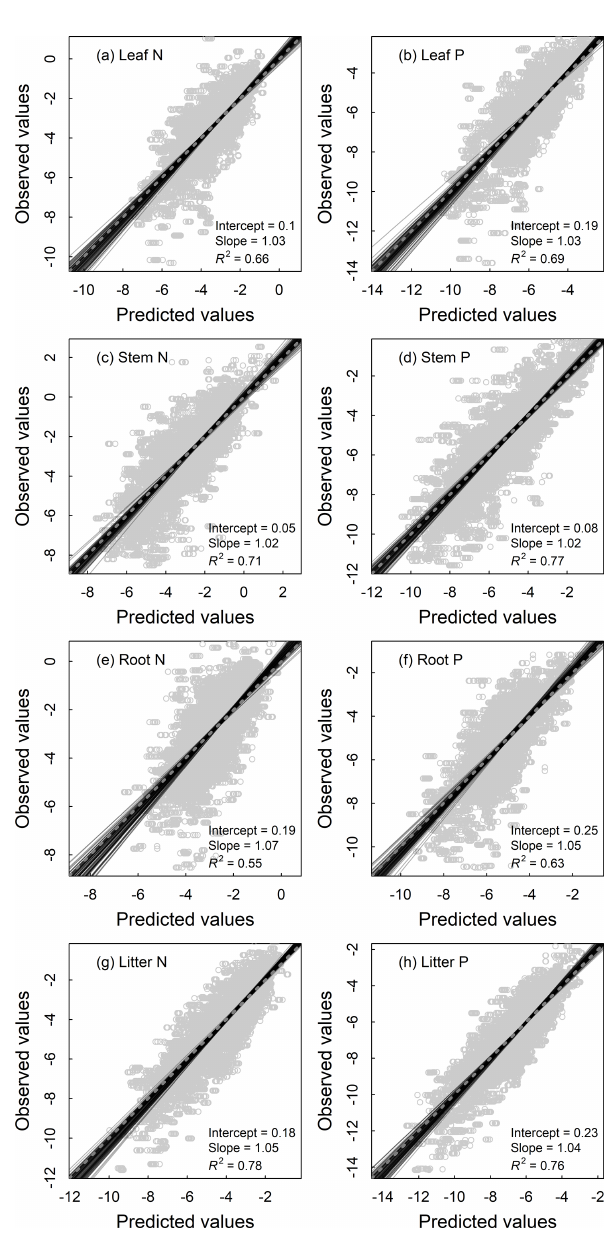
Figure 4. Fitting performance of random forest models for nutrient densities of leaves (a, b) , woody stems (c, d ), roots (e, f) , and litter (g, h) of terrestrial ecosystems in China based on 100 replications with the 10% validation data. Solid lines represent all the fitting lines, and the displayed parameters stand for the average conditions. The dashed line denotes the 1 : 1 line.